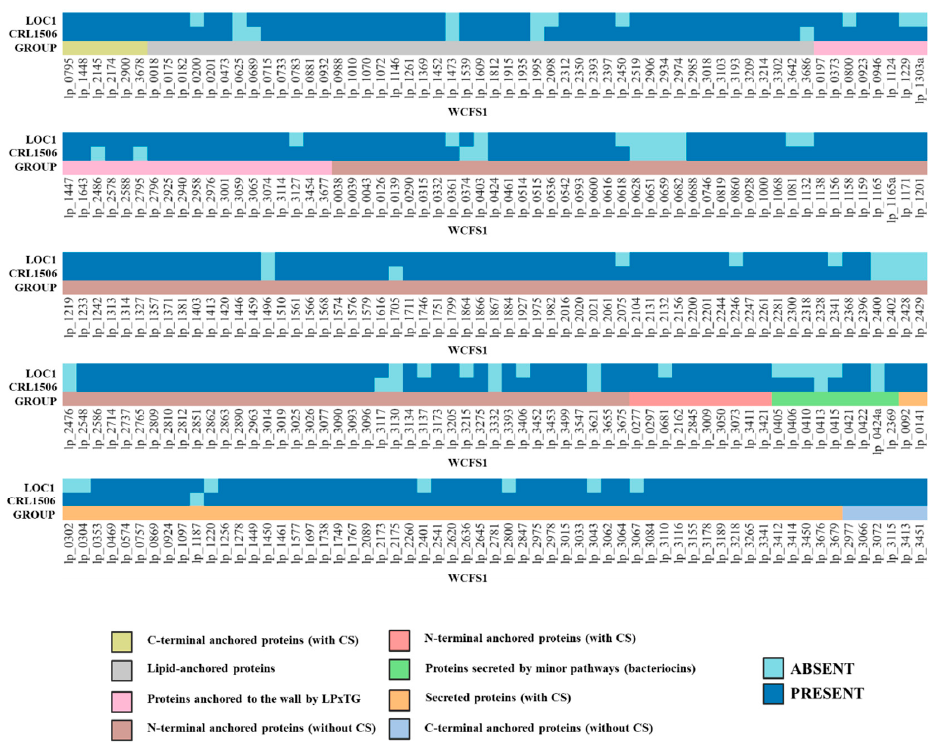
Figure 9. Analysis of the presence/absence of extracellular proteins in Lactiplantibacillus plantarum LOC1. The genomes of LOC1 and CRL1506 strains were studied and compared with the probiotic strain WCFS1 as reference ( lp_ genes). Proteins were grouped in C-terminal anchored proteins with and without cleavage sites (CS), N-terminal anchored proteins with and without CS, lipid-anchored proteins, proteins anchored to the wall by the LPxTG domain, secreted proteins with CS and proteins secreted by minor pathways.